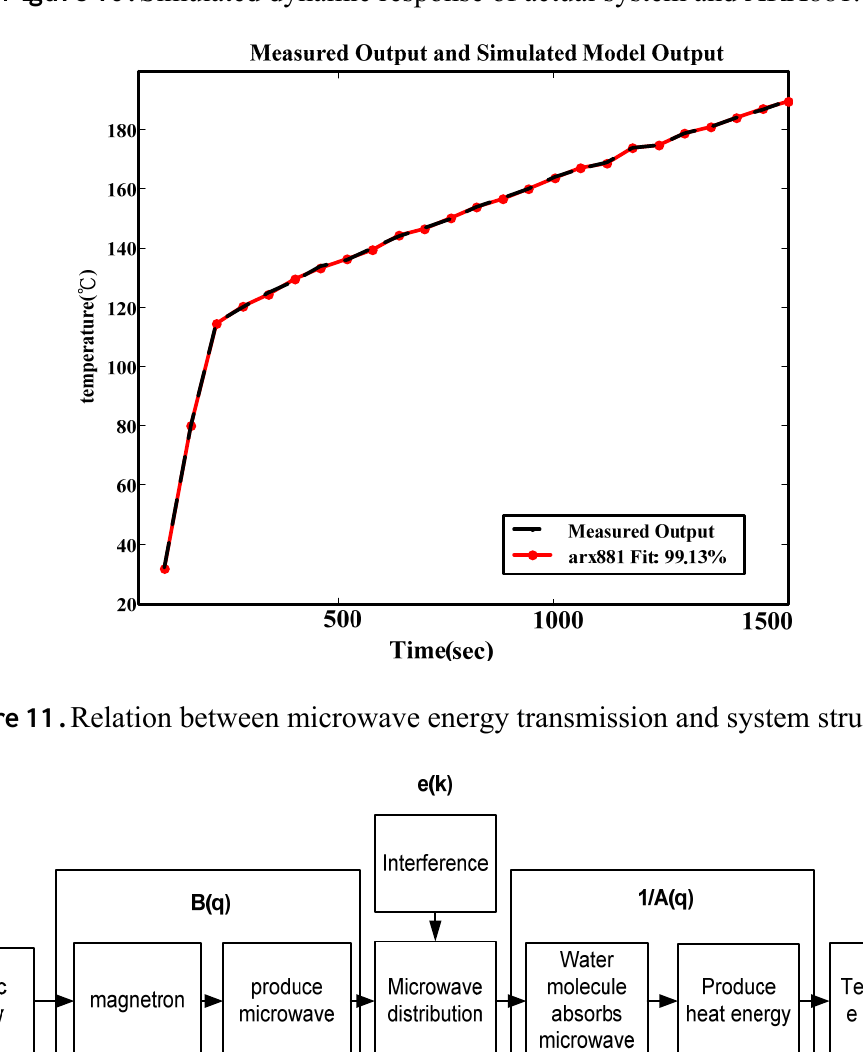
Figure 10. Simulated dynamic response of actual system and ARX881.